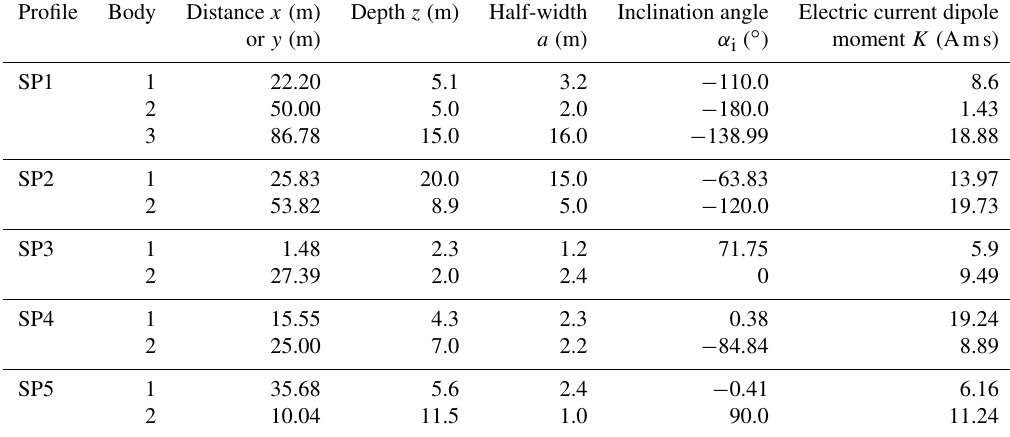
Table A1. Inversion results for SP modelling with the PSO method of Monteiro Dos Santos (2010). Profile Body Distance x (m) Depth z (m) Half-width Inclination